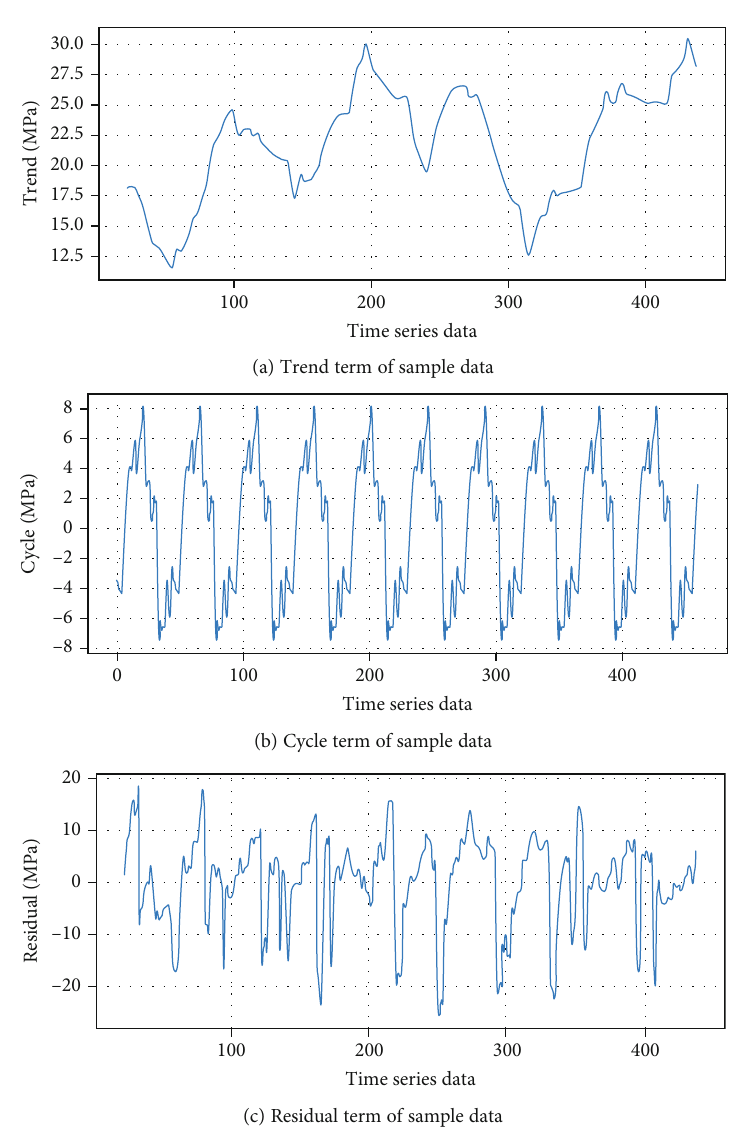
Figure 2: Feature decomposition of sample data of hydraulic support